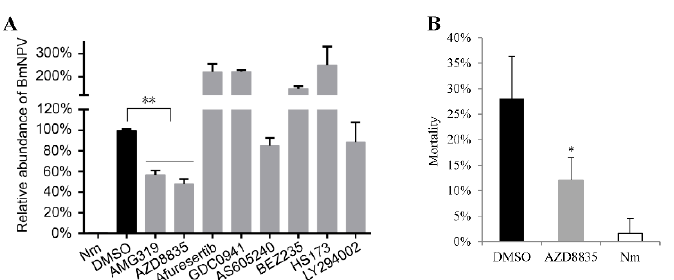
Figure 4. Analysis of the antiviral capacity of candidate drugs in treating silkworms. The third star larvae were orally infected with BmNPV and the drugs. DMSO: silkworms infected with virus and DMSO. Nm: non-infection control. ( A ) Analysis of the content of BmNPV DNA by qPCR. ( B ) Mortality. Bars: standard deviation; * p < 0.05 and ** p < 0.01.